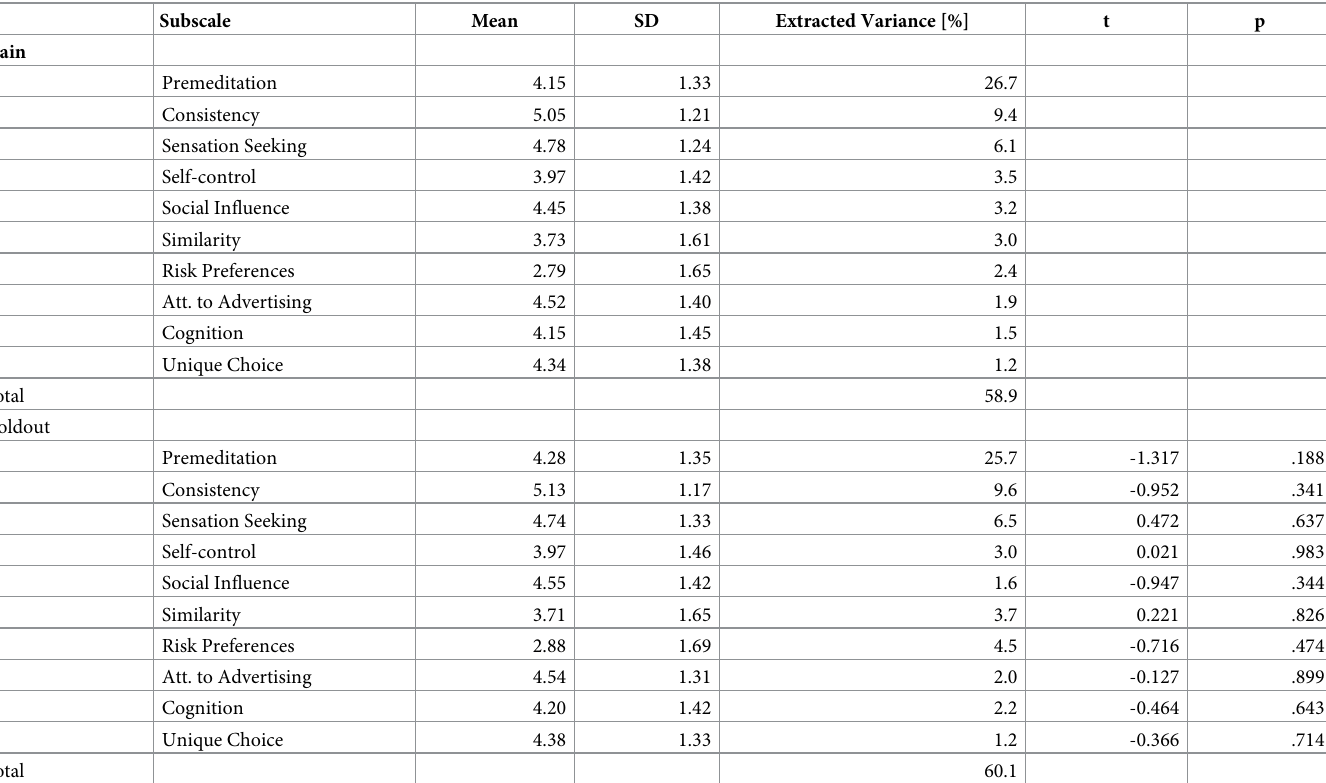
Table 3. Means, standard deviations, extracted variance, T-Test values, and significance of differences in StP-II main (n = 500) and holdout (n = 279)